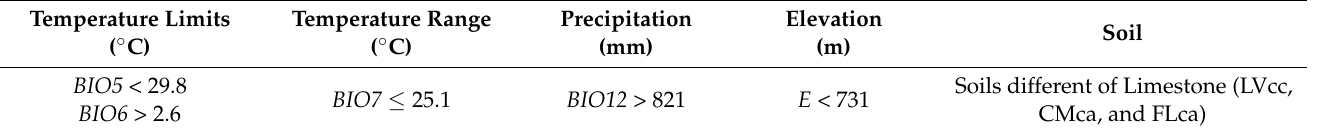
Table 3. Maritime pine ecological envelopes variables and thresholds [12].